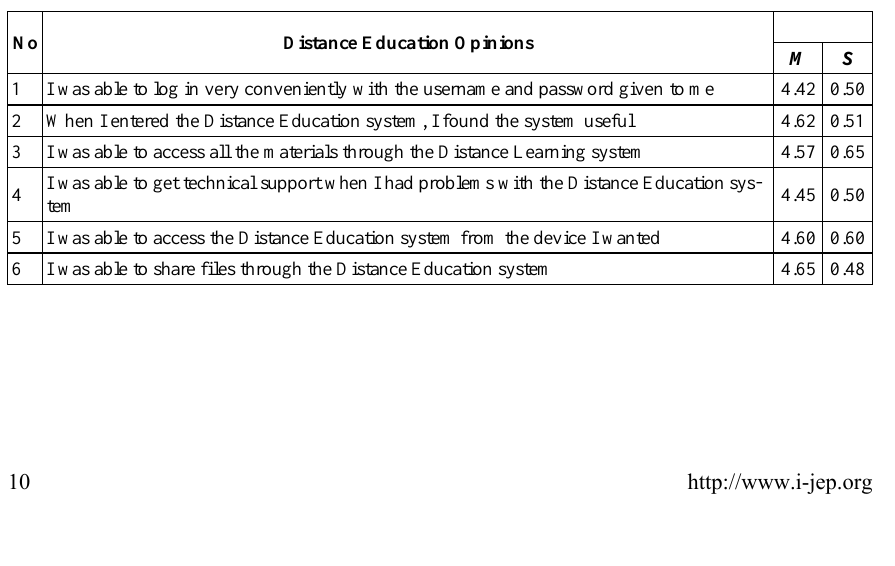
Table 5. Opinions of university students on distance